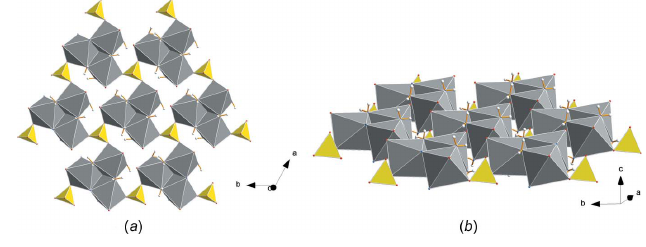
Figure 7 Interconnection of trimeric units within one layer by sulfate tetrahedra with the S1 sulfur atom viewed from two directions ( a and b ).